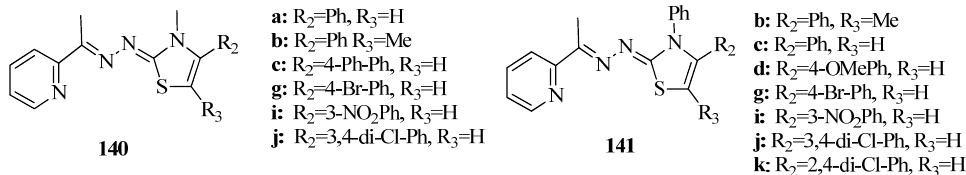
Figure 56. Structures of the active 2-(pyridin-2-yl)-1,3-thiazoles.